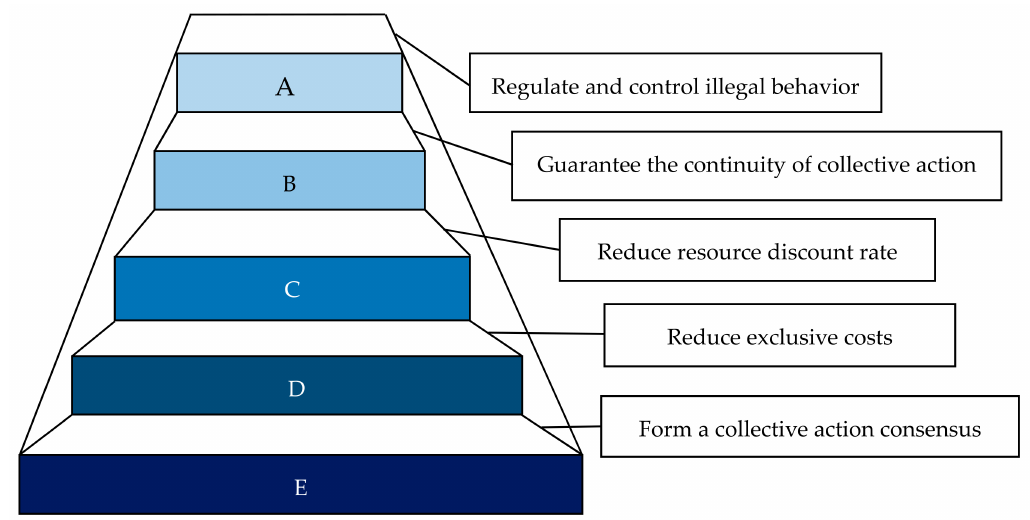
Figure 2. Incentive-compatible Collective Action Mechanism and Its Functions. A . The incentive compatibility mechanism of regulation; B . The incentive compatibility mechanism of power and responsibility; C . The incentive compatibility mechanism of behavior; D . The incentive compatibility mechanismofinterest; E .Theincentivecompatibilitymechanismofrecognition. Source: